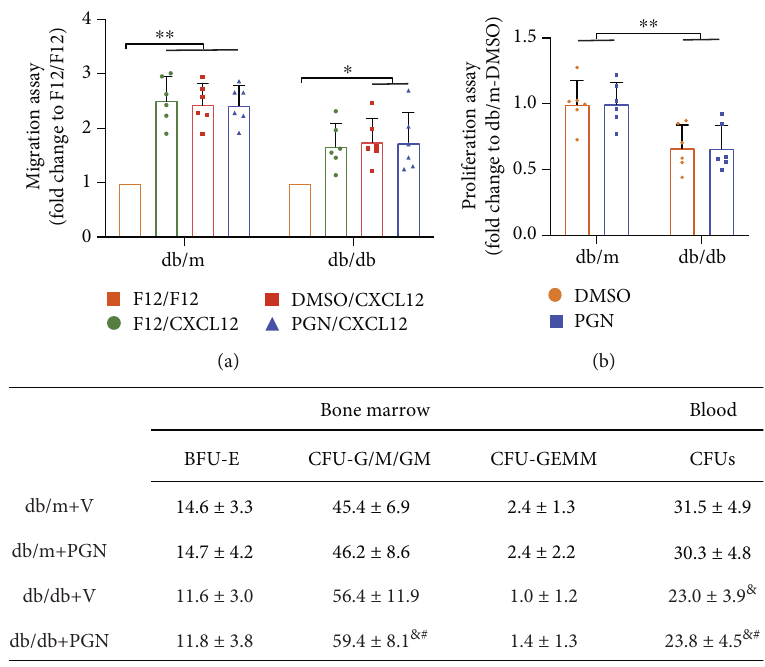
Figure 3: Ex vivo administration of PGN did not alter the vasoreparative functions or colony-forming ability of diabetic LK cells. (a, b) LK cells were isolated from db/m and db/db mice and treated with either PGN or vehicle ex vivo ( n = 6 per group). (a) Ex vivo PGN treatment did not further blunt the migration of LK cells from diabetic mice to the chemoattractant CXCL12 by the fl uorometric QCM 5 μ M96-well chemotaxis cell migration assay. (b) PGN-treated LK cells also showed similar proliferation ability measured by the proliferation BrdU ELISA kit in vitro. (c) CFU assay was used to determine the colony-forming abilities of BM and blood cells. The ex vivo administration of PGN did not alter the colony-forming abilities of BM and blood cells from diabetic mice ( n = 8 − 10 per group). Data represent mean ± SD . PGN: peptidoglycan; V: vehicle. ∗ P < 0 : 05 , ∗∗ P < 0 : 01 ; & compared to db/m+V, # compared to